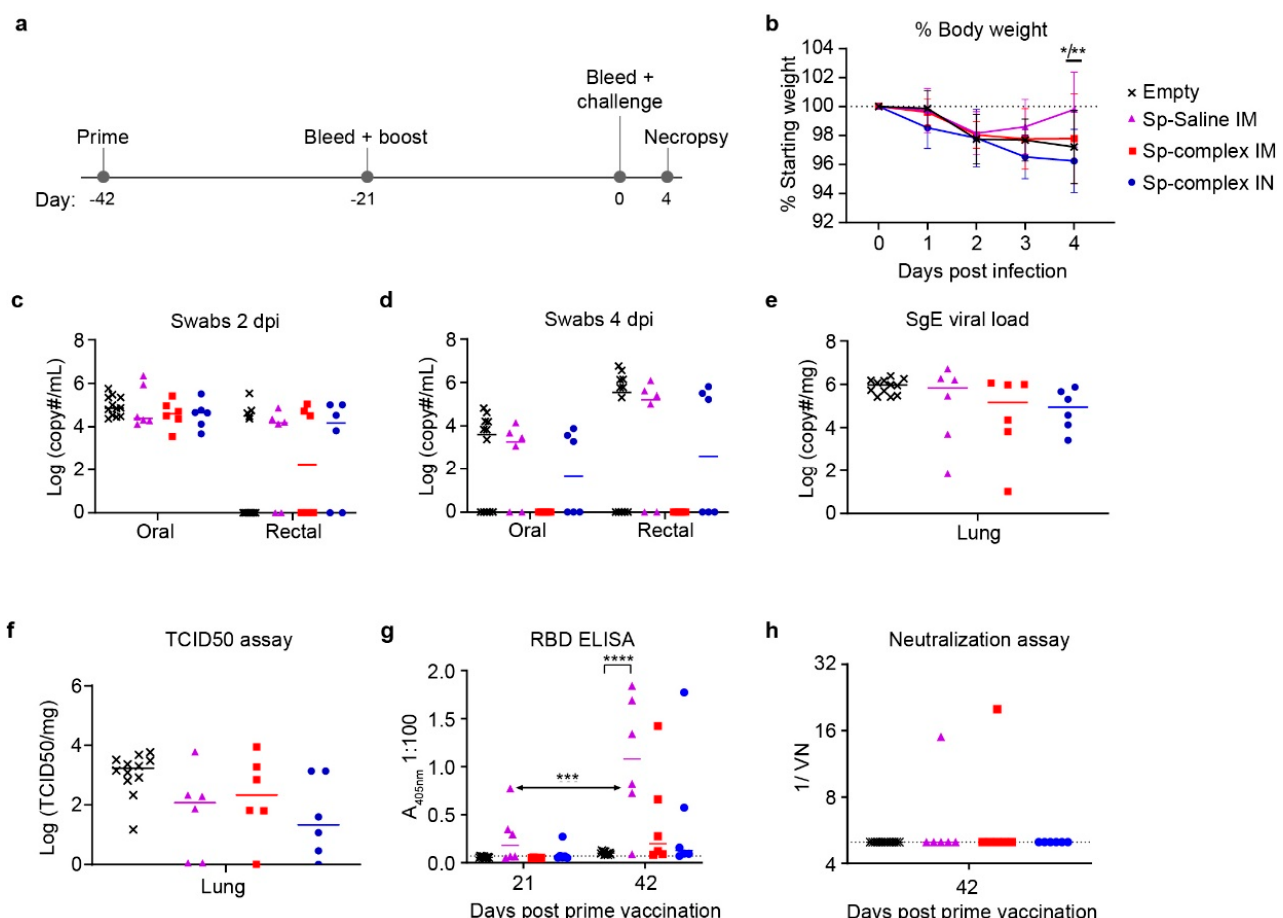
Figure 2. Prime-Boost Hamster Body Weight, Viral Loads, and Antibody Characterization. Prime-boost hamsters were divided into three spike-vaccinated groups receiving Sp_pVax1 IM vaccination of 100 µg DNA diluted in saline (Sp-Saline IM), IM vaccination of 50 µg Sp_pVax1 DNA complexed to in vivo delivery reagent (Sp-complex IM), and IN vaccination of 50 µg Sp_pVax1 DNA complexed to in vivo delivery reagent (Sp-complex IN). N = 12 for empty pVax1 group and N = 6 for Sp-vaccinated groups. ( a ) 3-weeks post prime, hamsters received boost and 3-weeks later were challenged IN with 1000 TCID 50 of SARS-CoV-2. ( b ) Animals were weighed daily to monitor weight loss, detailed weight loss for individual animals can be found in Appendix A Figure A2. ( c , d ) Viral shedding was measured in nasal and rectal swabs at ( c ) day 2 and ( d ) 4 PI. Viral loads in the lungs at day 4 PI were measured by ( e ) qRT-PCR and ( f ) TCID 50 . Antibody titers to the SARS-CoV-2 spike RBD were evaluated by ( g ) ELISA and ( h ) serum neutralizing capacity against infectious SARS-CoV-2 measured. Statistical analyses were done using Kruskal Wallis and 2-way ANOVA. * p < 0.05, ** p < 0.01, *** p < 0.001, **** p < 0.0001.